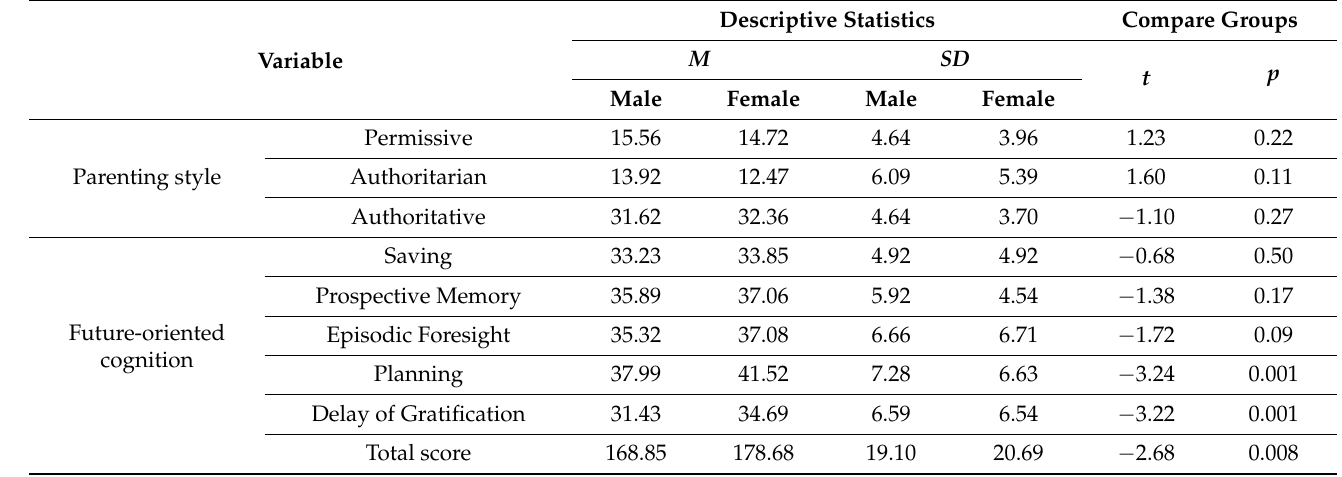
Table 1. Descriptive statistics of the study measures and a comparison between males’ and females’ future-oriented cognition skills and their parents’ parenting style ( n = 200).